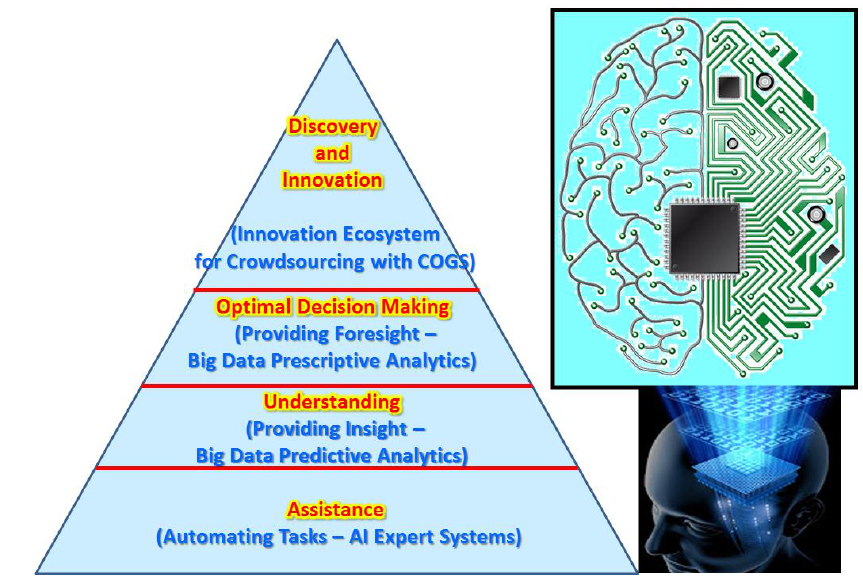
Figure 10: Augmenting and Amplifying human capability through cognitive computing and cognitive